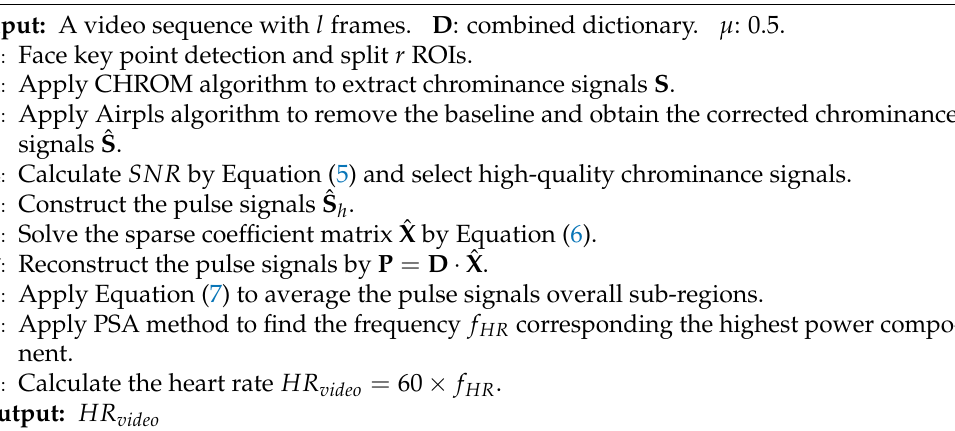
Algorithm 1 Remote Heart Rate Estimation by Pulse Signal Reconstruction Based on Structural Sparse